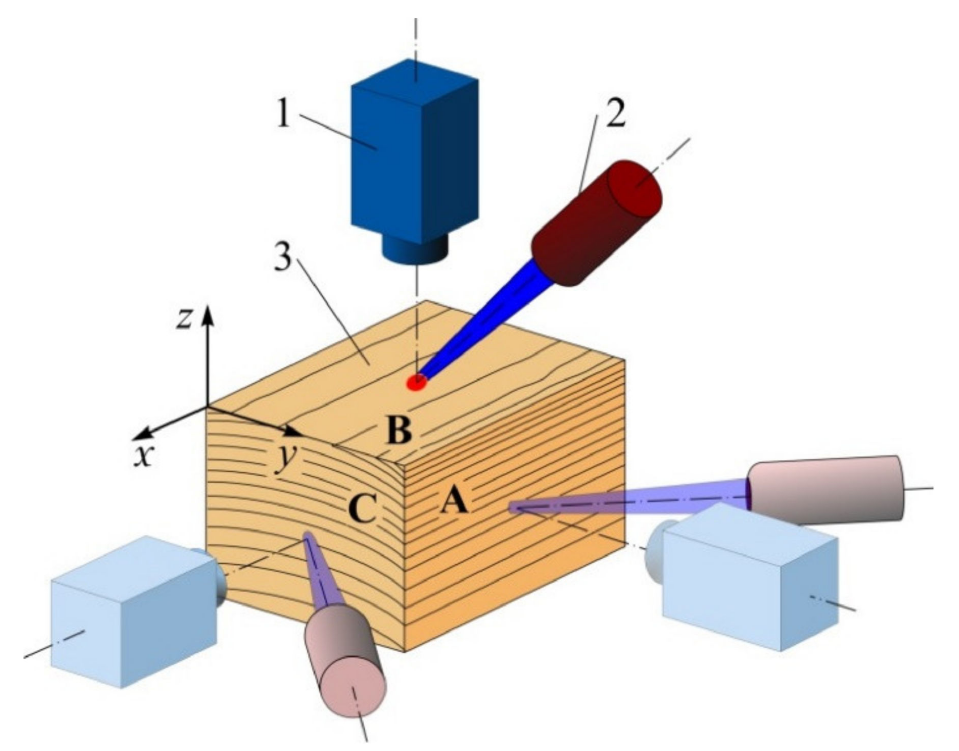
Figure 2. Thermal diffusivity measurement layout. 1—thermal camera, 2—laser, 3—wood sample, A—radial cut, B—tangential cut, C—crosscut.